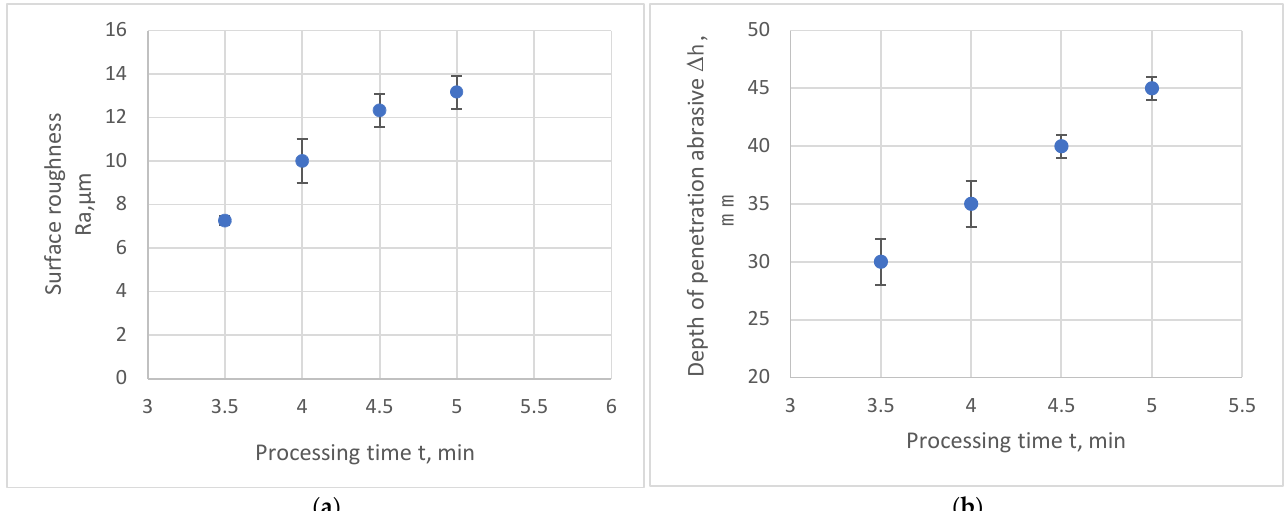
Figure 7. Dependence of the surface roughness Ra ( a ) and the depth of penetration of the abrasive ∆ h ( b ) on the processing time of the rod (air pressure P—0.6 MPa; nozzle attack angle—90 ◦ ). The standard deviation of surface roughness is the smallest for a processing time of 3.5 min (0.2 µ m) and the largest for a time of 4 min (1 µ